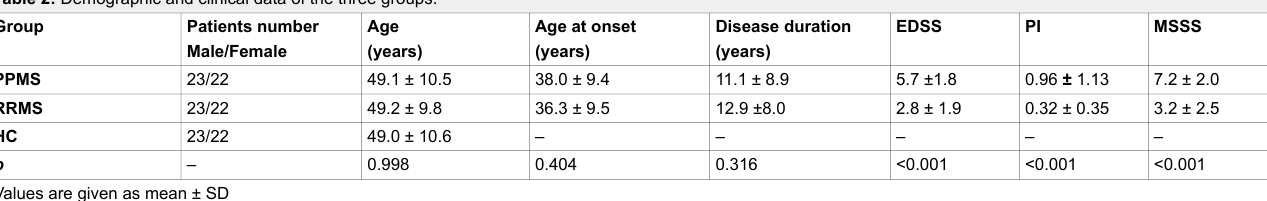
Table 2: Demographic and clinical data of the three groups.